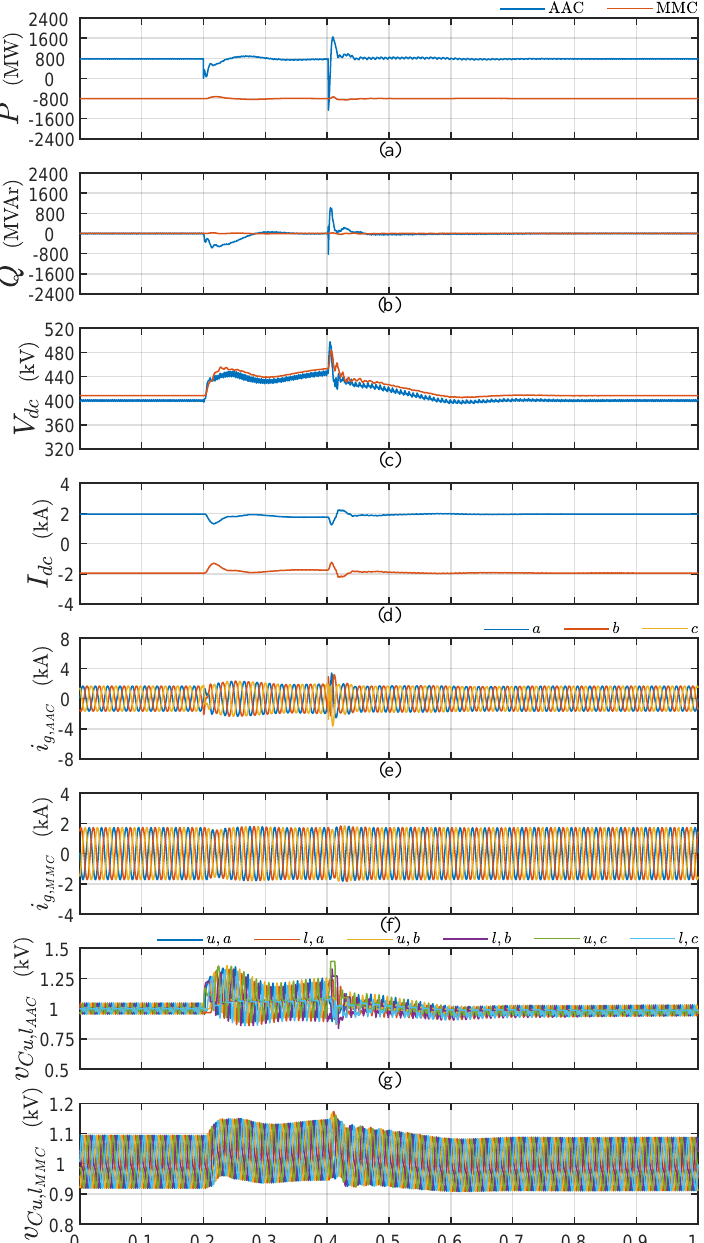
Figure 10. AAC three phase fault at 0.2 s: ( a ) active power, ( b ) reactive power, ( c ) dc-voltage, ( d ) dc- current, ( e ) ac currents of AAC, ( f ) ac currents of MMC, ( g ) SM capacitor voltages of AAC, and ( h ) SM capacitor voltages of